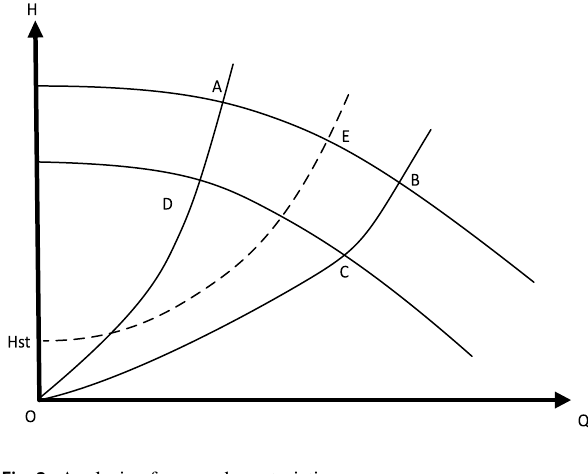
Fig. 2 Analysis of pump